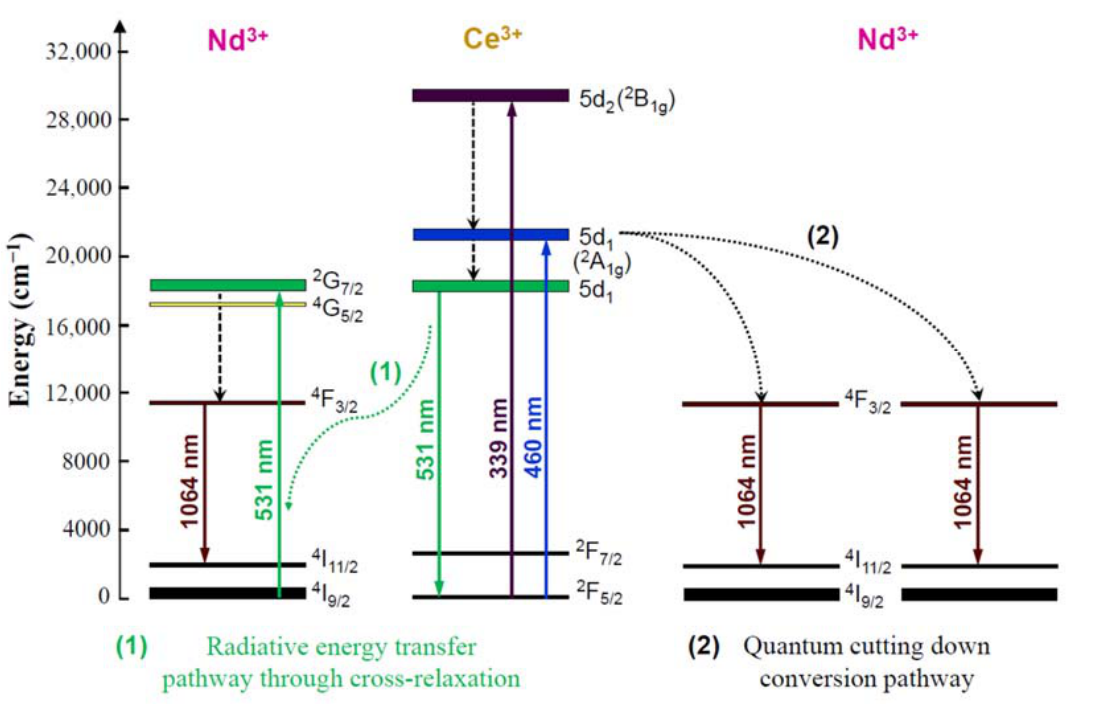
Figure 2. Energy ‐ level diagram representing the energy transfer between Ce 3+ and Nd 3+ ions in the Figure 2. Energy-level diagram representing the energy transfer between Ce 3+ and Nd 3+ ions in Ce:Nd:YAG material, adapted from [35]. (1) Radiative energy transfer pathway through cross ‐ the Ce:Nd:YAG material, adapted from [35]. ( 1 ) Radiative energy transfer pathway through cross- relaxation; (2) Quantum cutting down conversion pathway. relaxation; ( 2 ) Quantum cutting down conversion